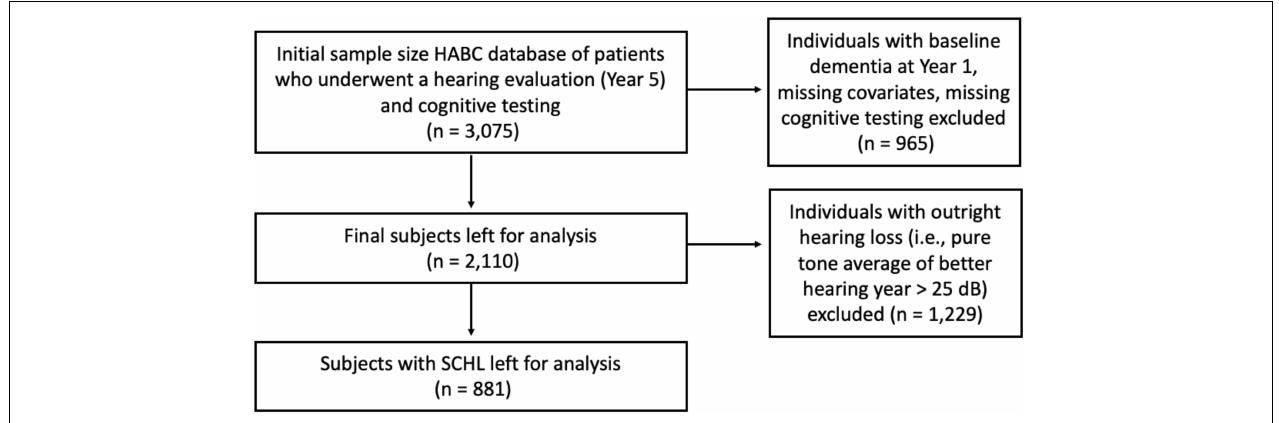
FIGURE 1 | Application of inclusion and exclusion criteria on initial